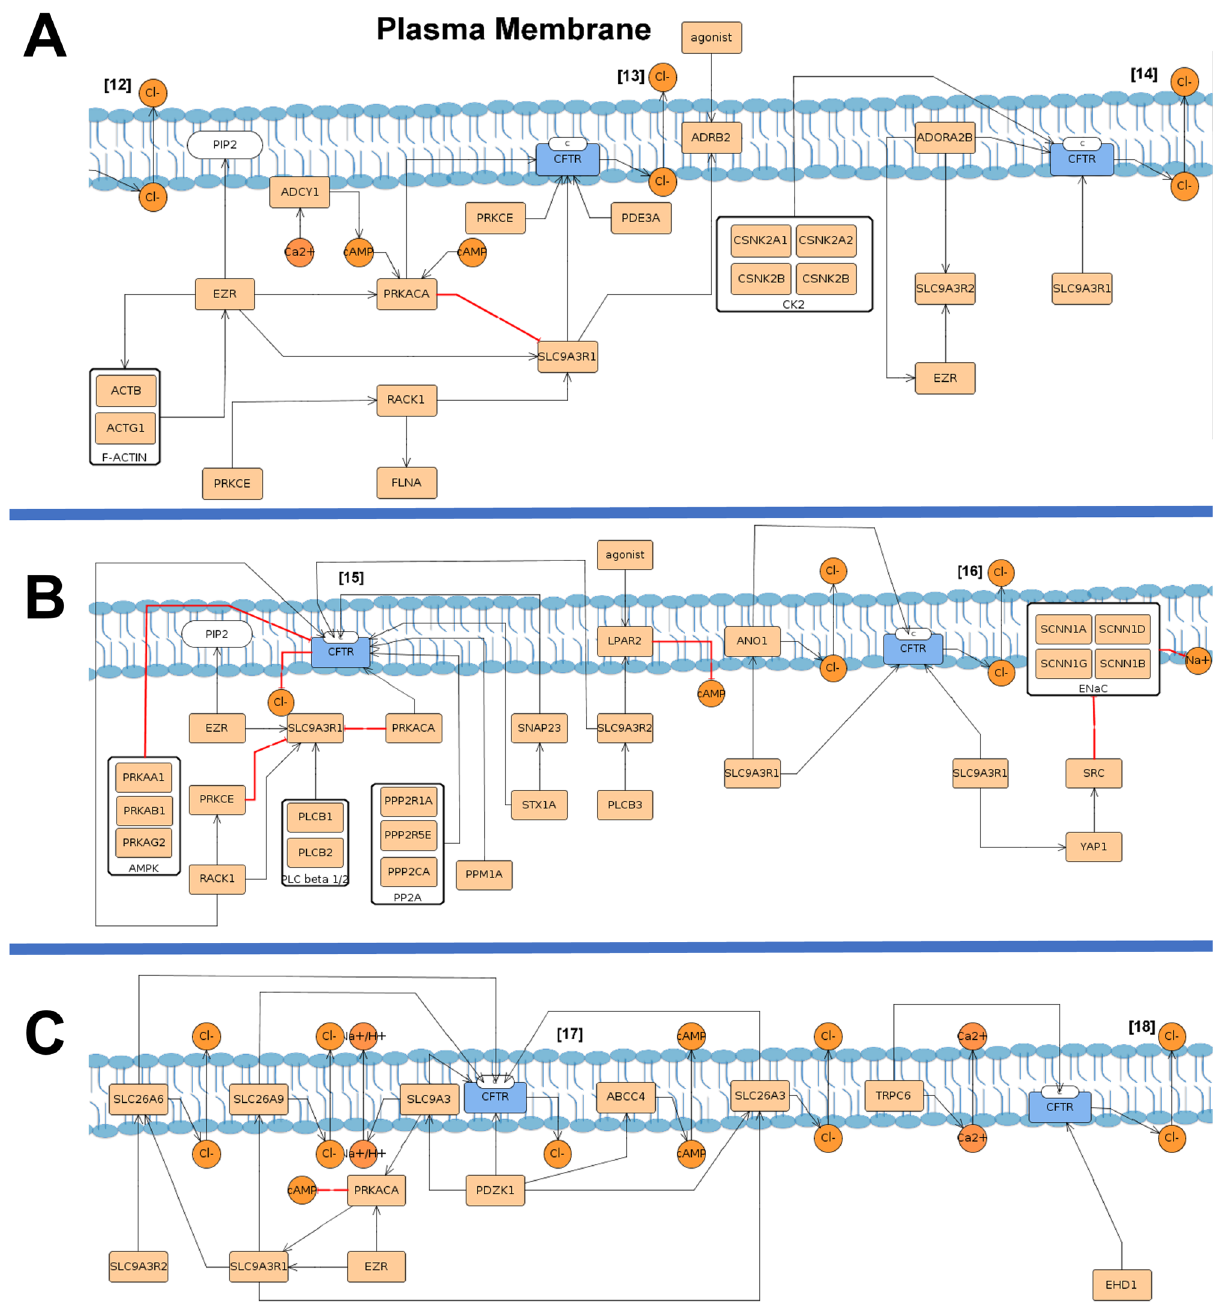
Figure 5. PM pathways in wt-CFTR submap. ( A ) Gating where is possible to see adenosine 3,5-cyclic monophosphate (cAMP) role in Protein Kinase CAMP-Activated Catalytic Subunit Alpha (PRKACA) phosphorylation that leads to CFTR activation and transport of chloride across the membrane. Other proteins are involved such as Adrenoceptor Beta 2 (ADRB2), Protein kinase CK2 (formerly known as casein kinase II), Adenosine A2b Receptor (ADORA2B) and Protein Kinase C Epsilon (PRKCE). ( B ) Shut-down with the action of Lysophosphatidic Acid Receptor 2 (LPAR2), serine/threonine protein kinase complex (AMPK), Phospholipase C beta ½ (PLC beta ½) and Protein phosphatase 2 (PP2A) where the chloride transport is inhibited. ( C ) Transporters and Ion channel regulation, in which the proteins that regulate and are regulated by CFTR at the PM are represented with the interactions